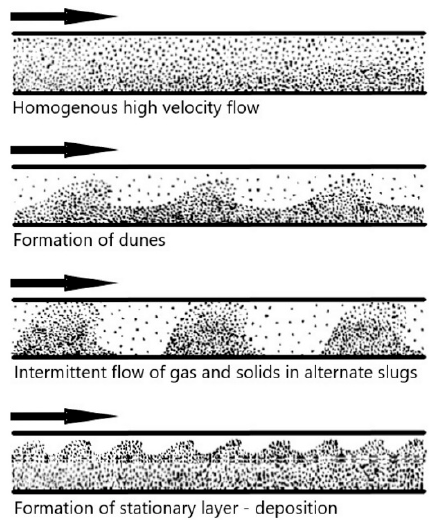
Figure 12. Flow patterns for glass beads